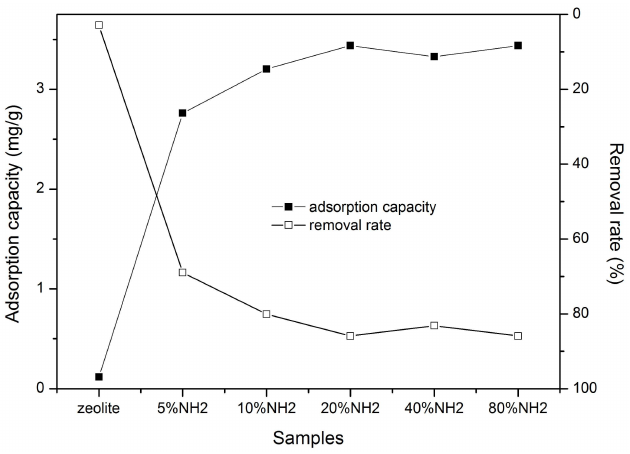
Figure 6. Adsorption properties of zeolite and amino functionalized zeolite samples with different silane dosage towards chromate ions.